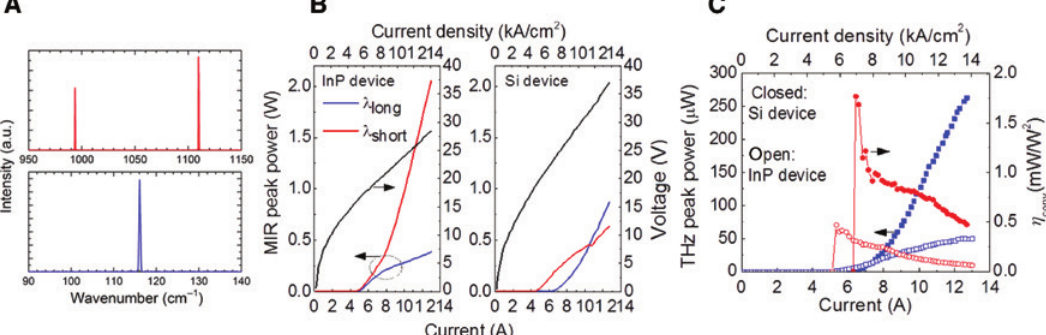
Figure 11: Device performance of the DFG-QCL on a HR-FZ Si substrate. (A) The emission spectra of the DFG-QCL on the HR-FZ Si substrate. All measurements were performed at 20 ° C under pulsed operation with 40-ns current pulses at 15-kHz repetition rate. (B) Light-current-voltage of the SI InP (left panel) and HR-FZ Si (right panel) devices. (C) THz peak power and mid-IR-to-THz conversion efficiency of the SI InP (open symbol) and HR-FZ Si (closed symbol) devices